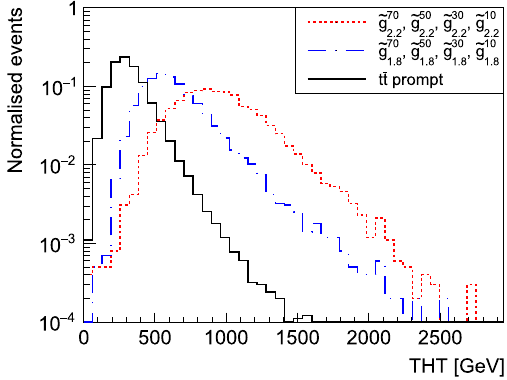
Fig. 76 Transverse momentum p T of the second leading jet in the gluino ˜ g case